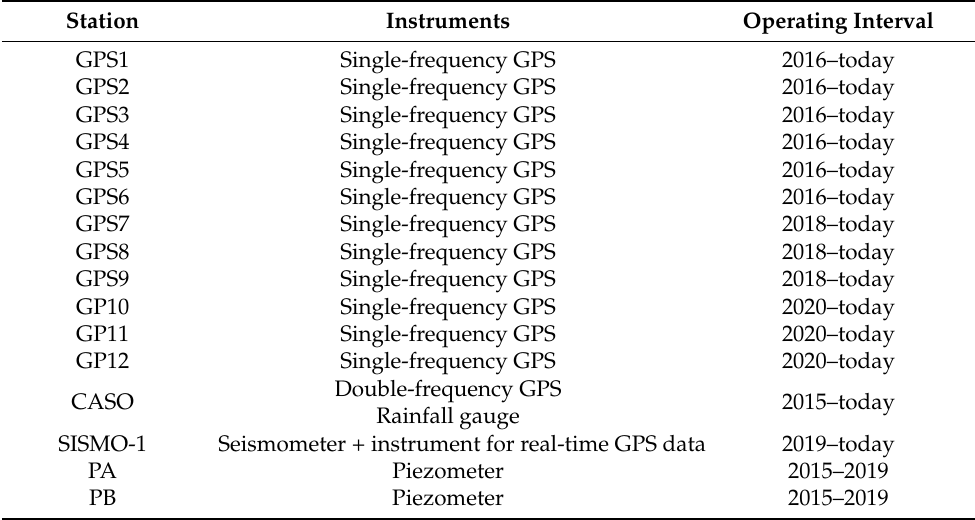
Table 1. Instrumentation belonging to the monitoring network installed on the Cazzaso